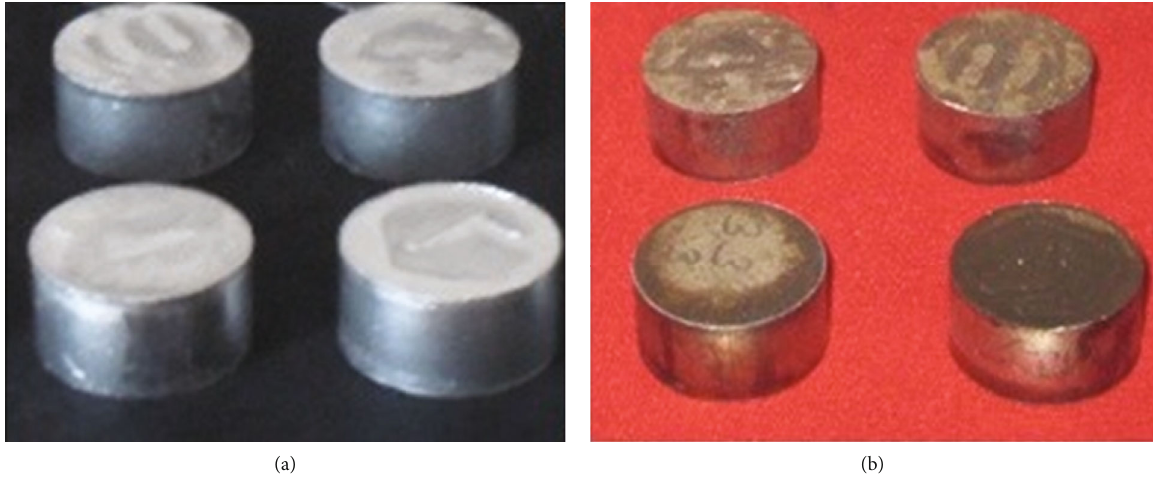
Figure 3: Compacted billets (a) before sintering and (b) after sintering.